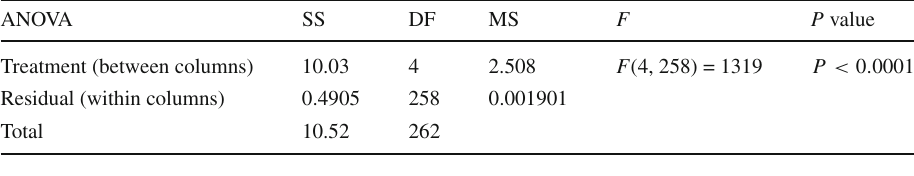
Table 4 Delta estimate values of one-way ANOVA with 95% confidence